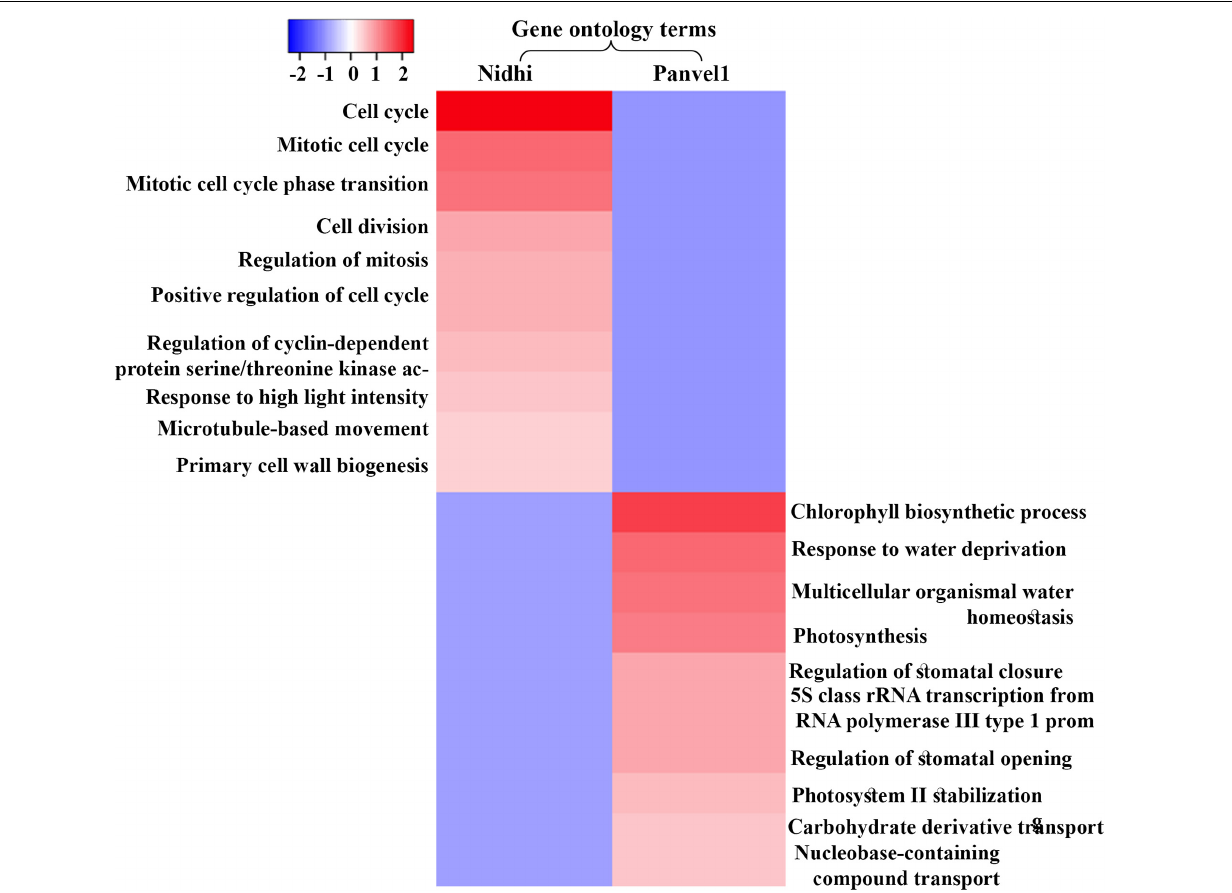
Frontiers in Plant Science |